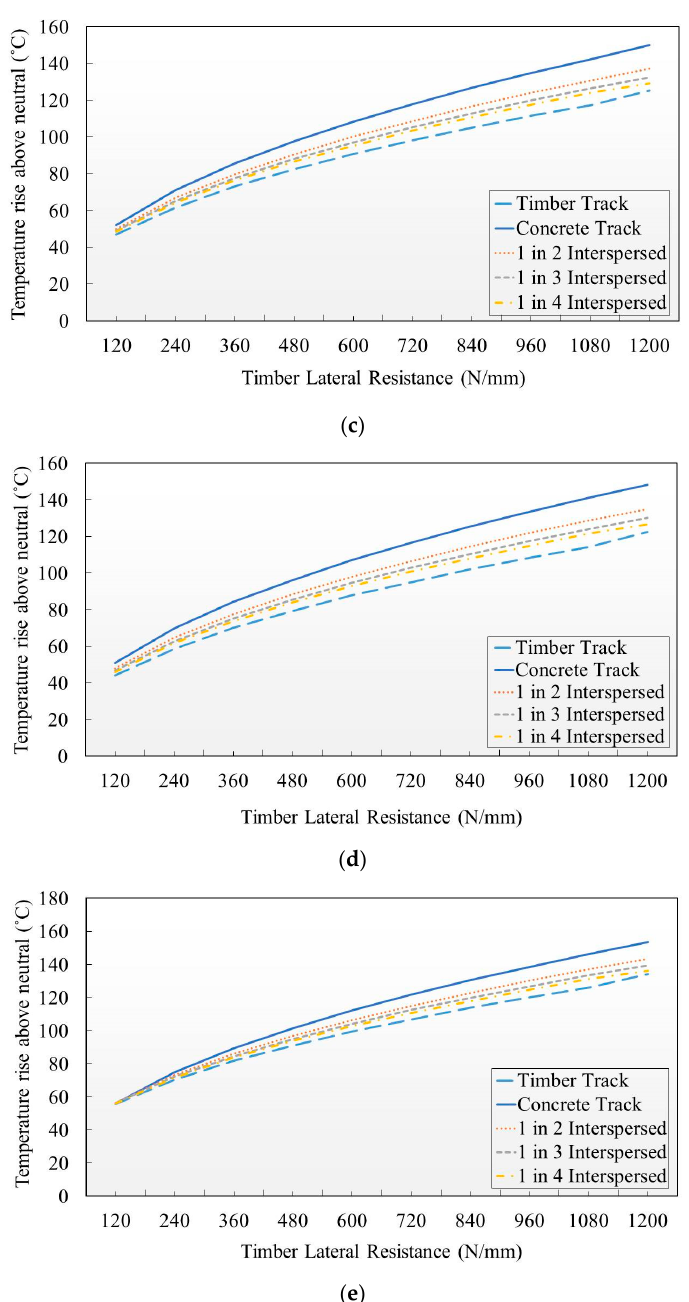
Figure 7. Temperature rise above neutral: ( a ) Nominal torsional resistance value; ( b ) 50% reduction of nominal torsional resistance value; ( c ) 25% reduction of nominal torsional resistance value; ( d ) 25% increase of nominal torsional resistance value; ( e ) 50% increase of nominal torsional resistance value.